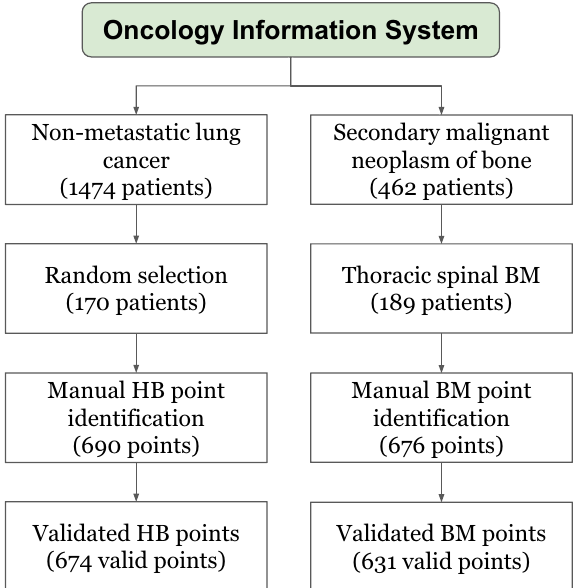
Figure 1. Flow chart of patient selection.